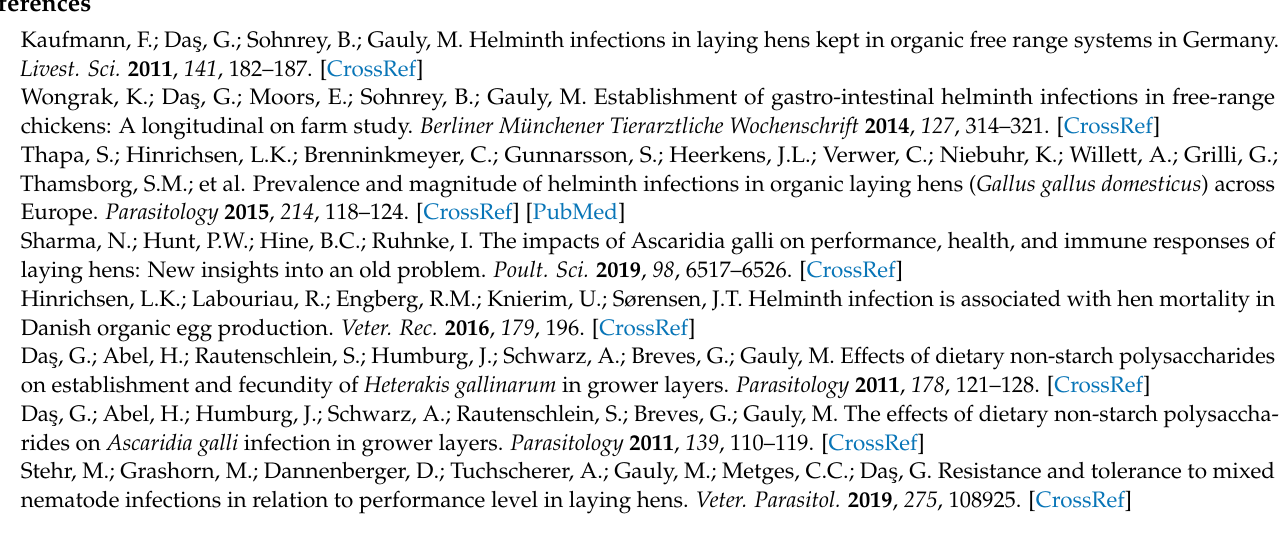
nematodes (B), Table S1: Transcriptome alignment summary, Table S2: Results of differential gene expression